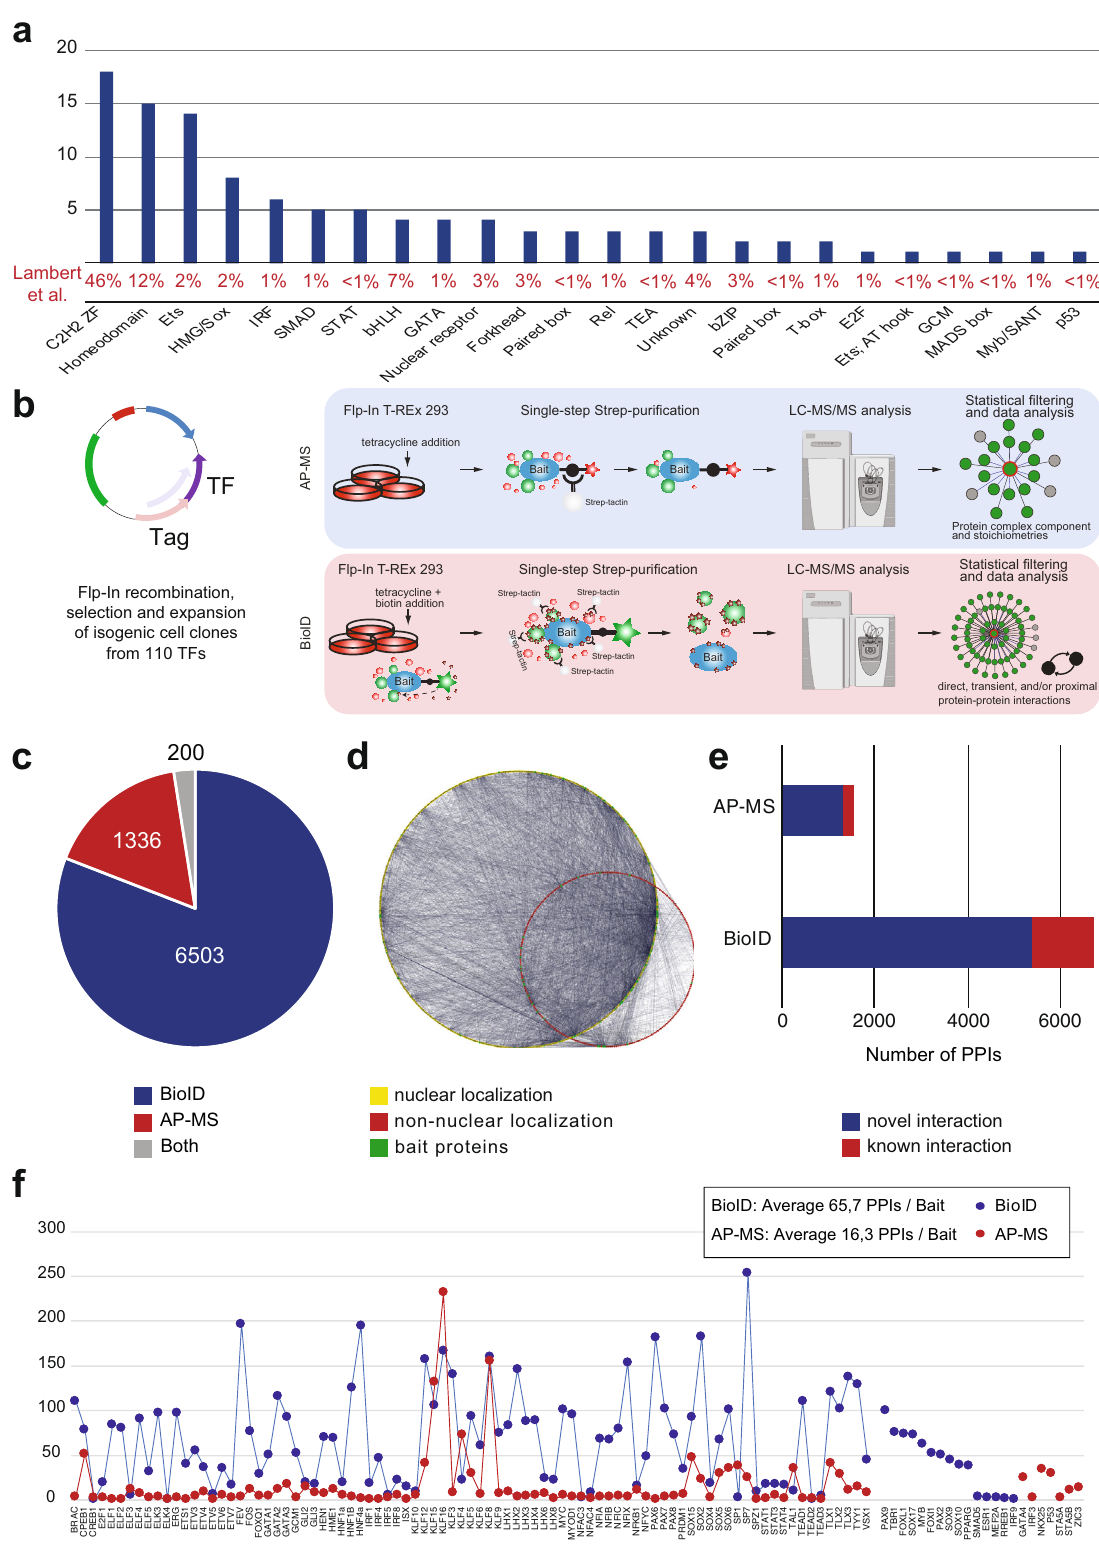
To obtain a glimpse to the biological nature of TF interactions, we performed Gene Ontology biological process (GO-BP) enrichment analysis for all BioID interactions (Fig. 3a, Supple- mentary Data 4). As expected, BP terms linked to transcription and its regulation were signi fi cantly enriched. The most